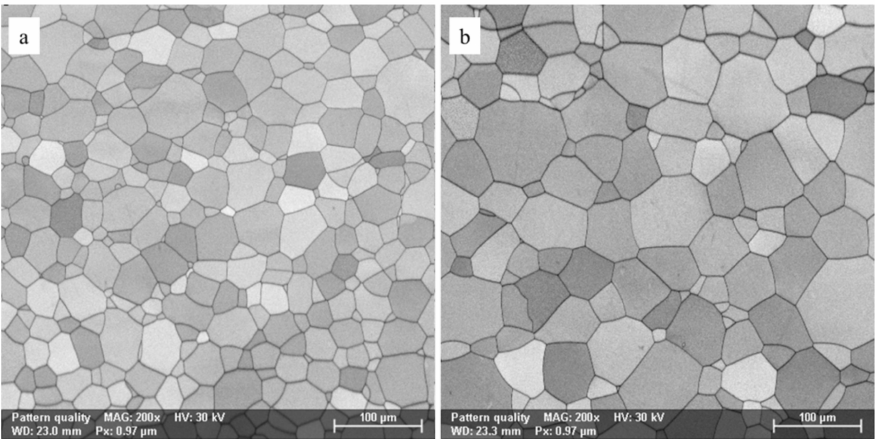
Figure 9. OM microstructure of the Ti29.3Nb13.6Zr1.9Fe alloy recrystallized after 5 min ( a ) and after 15 min ( b